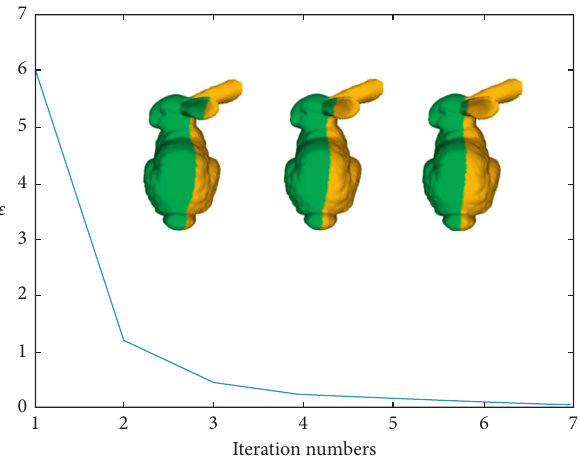
Figure 4: The convergence property of the proposed